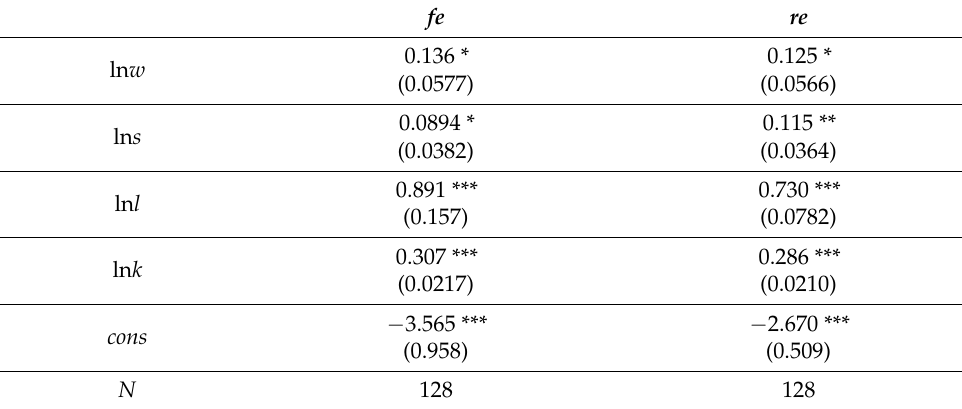
Table 3. Results of the extended Cobb–Douglas production function model.